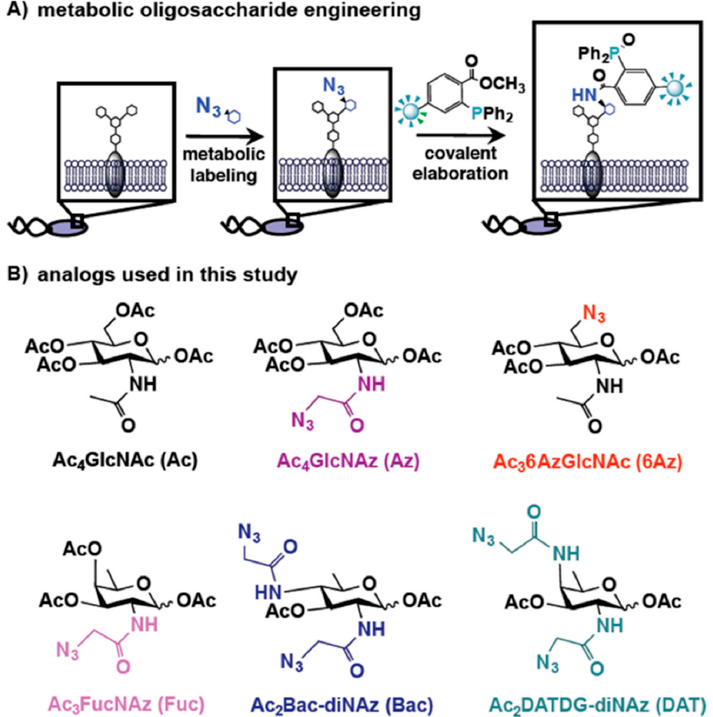
Figure 5. Schematic overview of metabolic oligosaccharide engineering (MOE) experiments and structures of monosaccharide analogs used in this study. ( A ) In MOE experiments, cells are first metabolically labeled with an unnatural azide-containing sugar. Azide-bearing glycans then un- dergo Staudinger ligation with phosphine probes to enable their detection on cells or in cell lysates. ( B ) Metabolic incorporation of azide-containing analogs of the naturally abundant monosaccharide GlcNAc, as well as of the rare bacterial monosaccharides FucNAc, bacillosamine, and DATDG, was explored in this work. Reproduced with permission from Ref. [45]. Copyright 2016, American Chemical